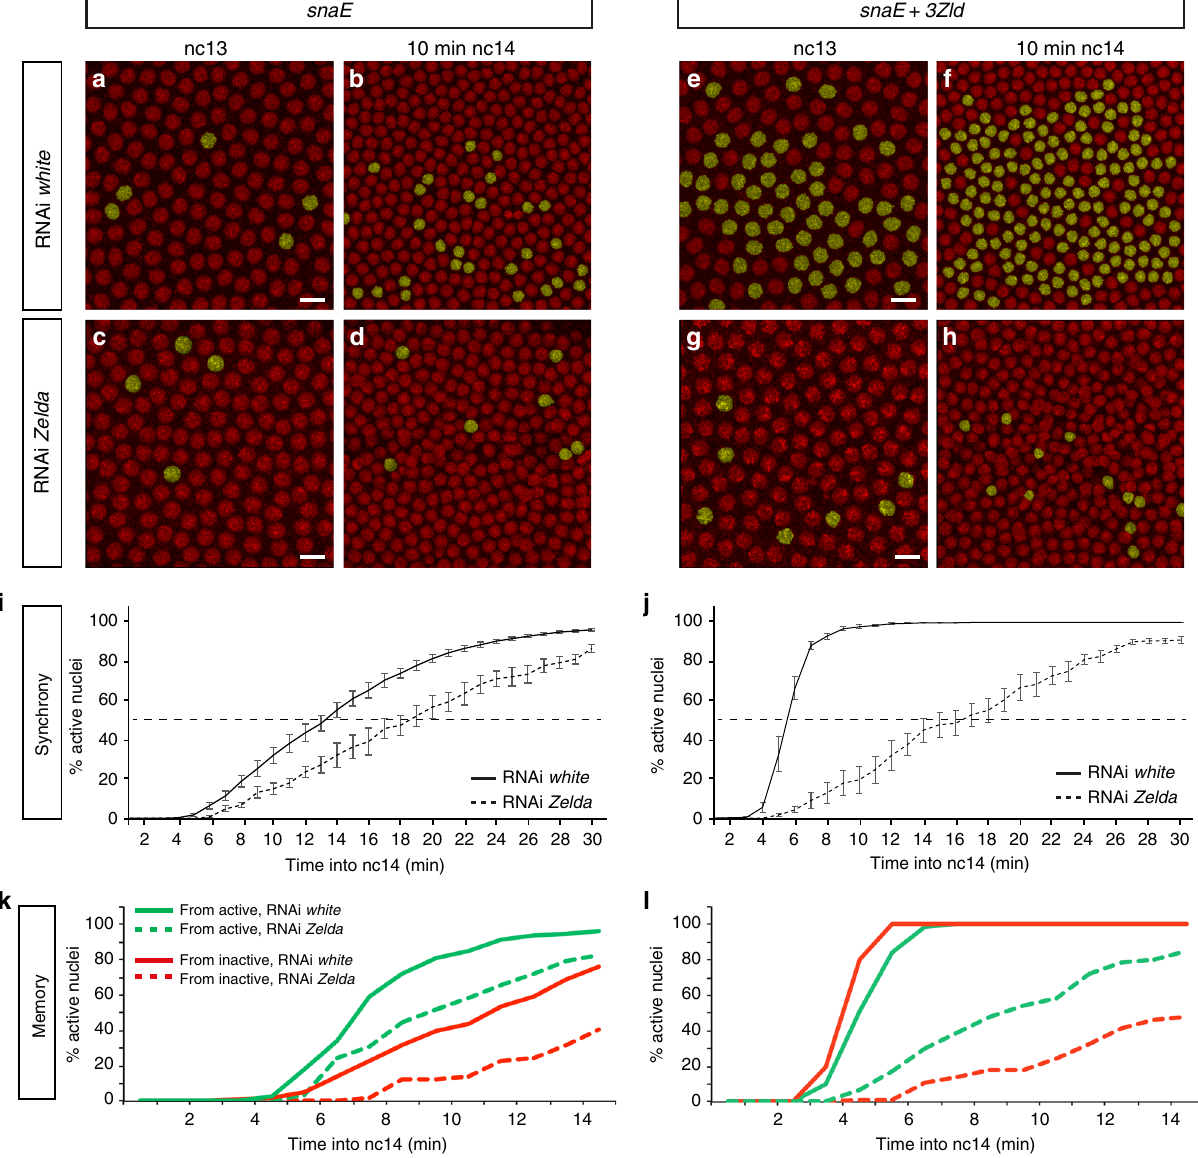
Fig. 3 Transcriptional memory persists in the absence of Zelda. a – h Snapshots of maximum intensity projected Z-stack of Drosophila embryo movies expressing snaE ( a – d ) or snaE + 3Zld ( e – h ) at nc13 ( a , c , e , g ) and nc14 ( b , d , f , h ), in a white -RNAi ( a , b , e , f ) or in a zld -RNAi genetic background ( c , d , g , h ). Nuclei exhibiting a spot of active transcription are false-colored in yellow. i , j Temporal coordination of all activated nuclei in nc14 for snaE ( i ) and snaE + 3Zld transgene ( j ), in a white -RNAi (solid curves) and in a zld -RNAi genetic background (dashed curves). Statistics: snaE white -RNAi: 9 movies, n = 972; snaE zld -RNAi: 4 movies n = 156; snaE + 3Zld white -RNAi: 6 movies n = 541; snaE + 3Zld zld -RNAi: 5 movies n = 160. Error bars represent SEM. k , l Kinetics of activation during the fi rst 15 min of nc14 driven by the snaE transgene or the snaE + 3Zld transgene in white -RNAi (solid curves) or in zld -RNAi embryos (dashed curves). The kinetics of nuclei coming from transcriptionally active mothers in nc13 (green curves) is compared to those arising from inactive mothers (red curves). Statistics: snaE white -RNAi: 6 movies, n = 302; snaE zld -RNAi: 4 movies n = 86; snaE + 3Zld white -RNAi: 6 movies n = 273; snaE + 3Zld zld -RNAi: 5 movies n = 111). In Fig. 3, only nuclei located within a 25 μ m rectangle centered around the ventral furrow/pseudo-furrow for zld -RNAi are considered. Scale bars represent 10 μ